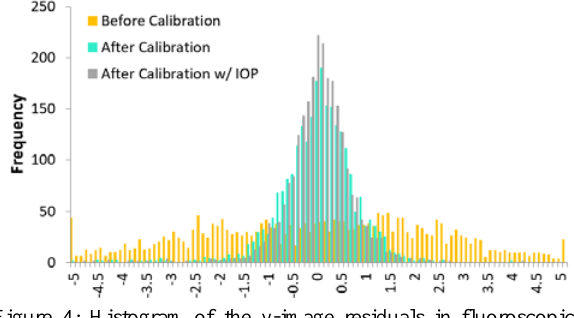
Figure 4: Histogram of the y-image residuals in fluoroscopic system 1